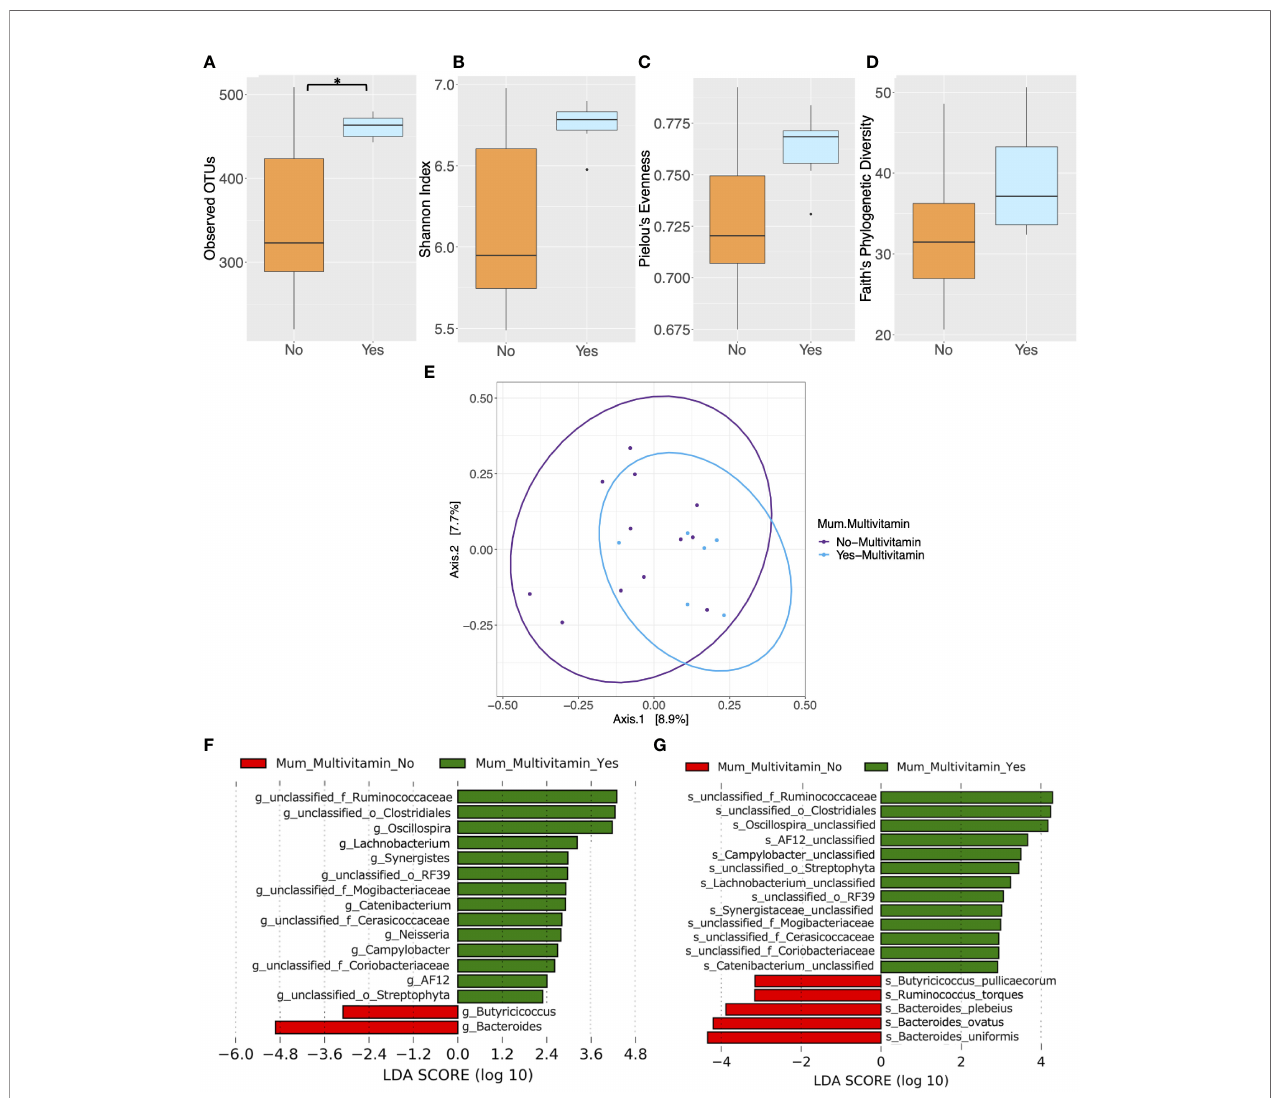
FIGURE 4 | Comparison of microbiota composition and diversity between mothers who took multivitamins ( n = 6) and those who did not ( n = 12) based on faecal samples collected at 6 months postpartum. Alpha diversity measured by (A) Observed operational taxonomic units (OTUs) (B) Shannon index (C) Pielou ’ s evenness (D) Faith ’ s phylogenetic diversity. Yes = mother took multivitamins, No = mother did not take multivitamins. Boxes represent the interquartile range (IQR), the line inside the box indicates the median and whiskers represent values 1.5 × IQR from the fi rst and third quartiles respectively. Differences between groups were tested using the Wilcoxon sum rank test and false discovery rate (FDR) corrected. *P < 0.05 (E) Principal Coordinates Analysis (PCoA) of microbiota community structure based on maternal multivitamin intake. The points represent individual samples from mothers and the ellipse illustrates the 95% con fi dence intervals of multivariate normal distribution. (F) Differentially abundant bacterial genera as identi fi ed by Linear discriminant analysis Effect Size (LEfSe). (G) Differentially abundant bacterial species as identi fi ed by LEfSe. Bacterial taxa were classi fi ed as differentially abundant if their P value was < 0.05 and their linear discriminant analysis (LDA) log score was > 2. Taxa enriched in mothers who did not take multivitamins are indicated by red, and taxa enriched in those who did take multivitamins are indicated by green. Taxon levels are abbreviated with p, phylum; c, class; o, order; f, family; g, genus and s, species. LDA effects sizes and signi fi cant P values are in Supplementary Tables 10 – 11